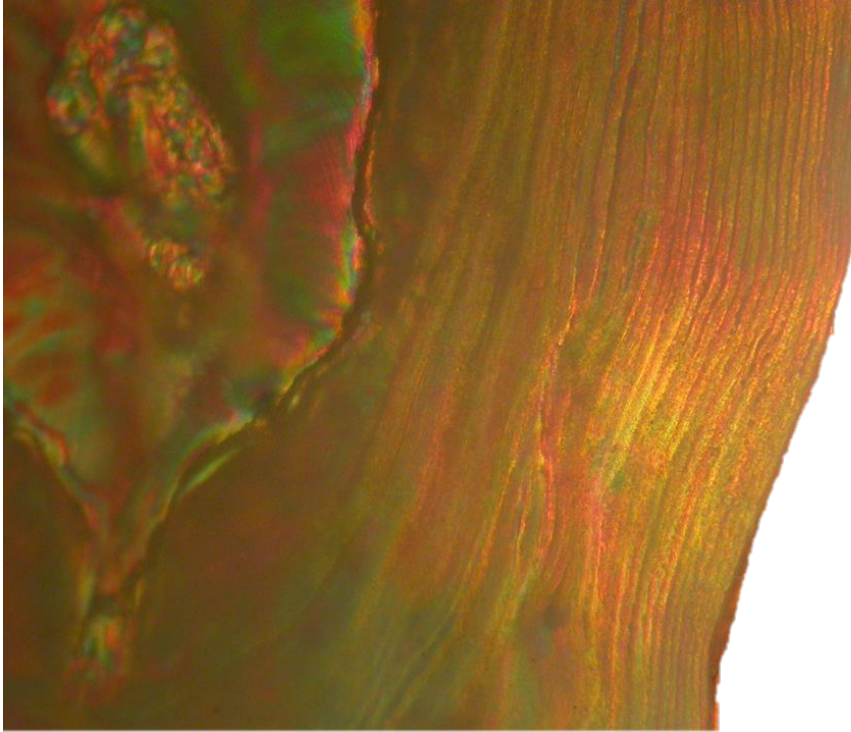
Fig. 4. Walrus ( Odobenus rosmarus ) cementum in untreated tooth section viewed under polarised transmitted